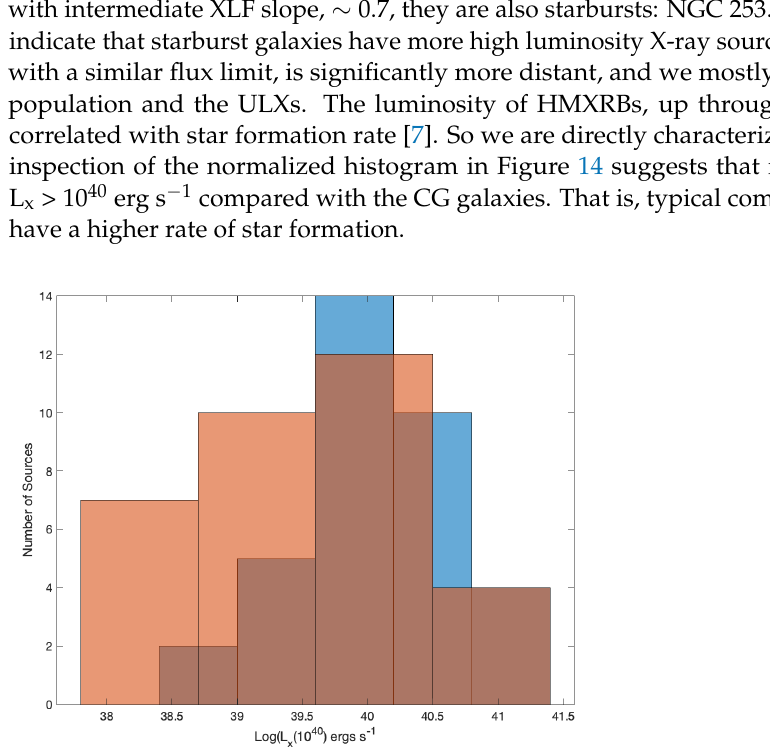
Figure 14. Approximately normalized histogram of IGL disk (orange) and CG (blue) sources. There is a correlation between the fraction of elliptical galaxies and the amount of diffuse light in Hickson compact groups. Those with a large fraction of diffuse light are those with large fractions in number and luminosity of E/S0 galaxies. This indicates that the diffuse light is mainly created in dynamical processes during the formation of bright elliptical galaxies in major mergers [17]. Using N-body simulations, ~40% of the cluster’s ICL is generated in the form of massive, dynamically cold streams. The production of streams requires strong tidal fields such as those due to close interaction between pairs of galaxies, and with merging of pairs of galaxies in clusters [23]. The simulations agree with observations, where 80 per cent of the stripped stars are placed in the ICL component